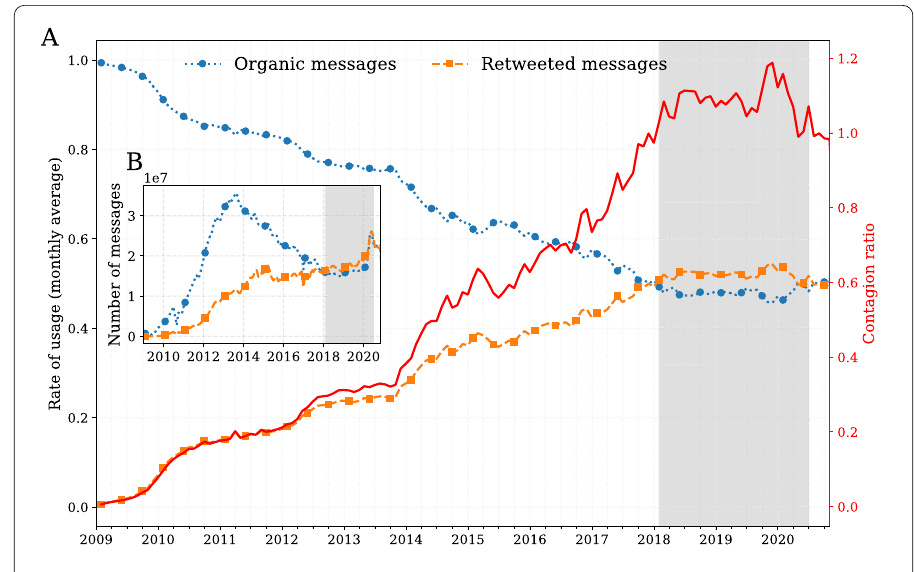
Figure 4 Timeseries for organic messages, retweeted messages, and average contagion ratio for all languages. ( A ) Monthly average rate of usage of organic messages ( p ( OT ) , orange). The solid red line highlights the steady rise of the contagion ratio R (cid:2) , t . ( B ) Frequency of organic ( p ( RT ) t , (cid:2) , blue), compared to retweeted messages ( f ( RT ) messages ( f ( OT ) (cid:2) , t starting in early 2018 highlights an interesting shift on the platform where the number of retweeted